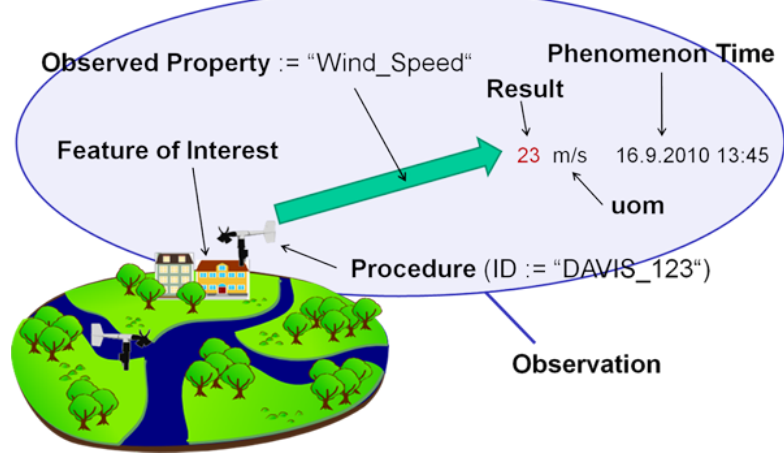
Figure 1. The Sensor Observation Service (SOS)